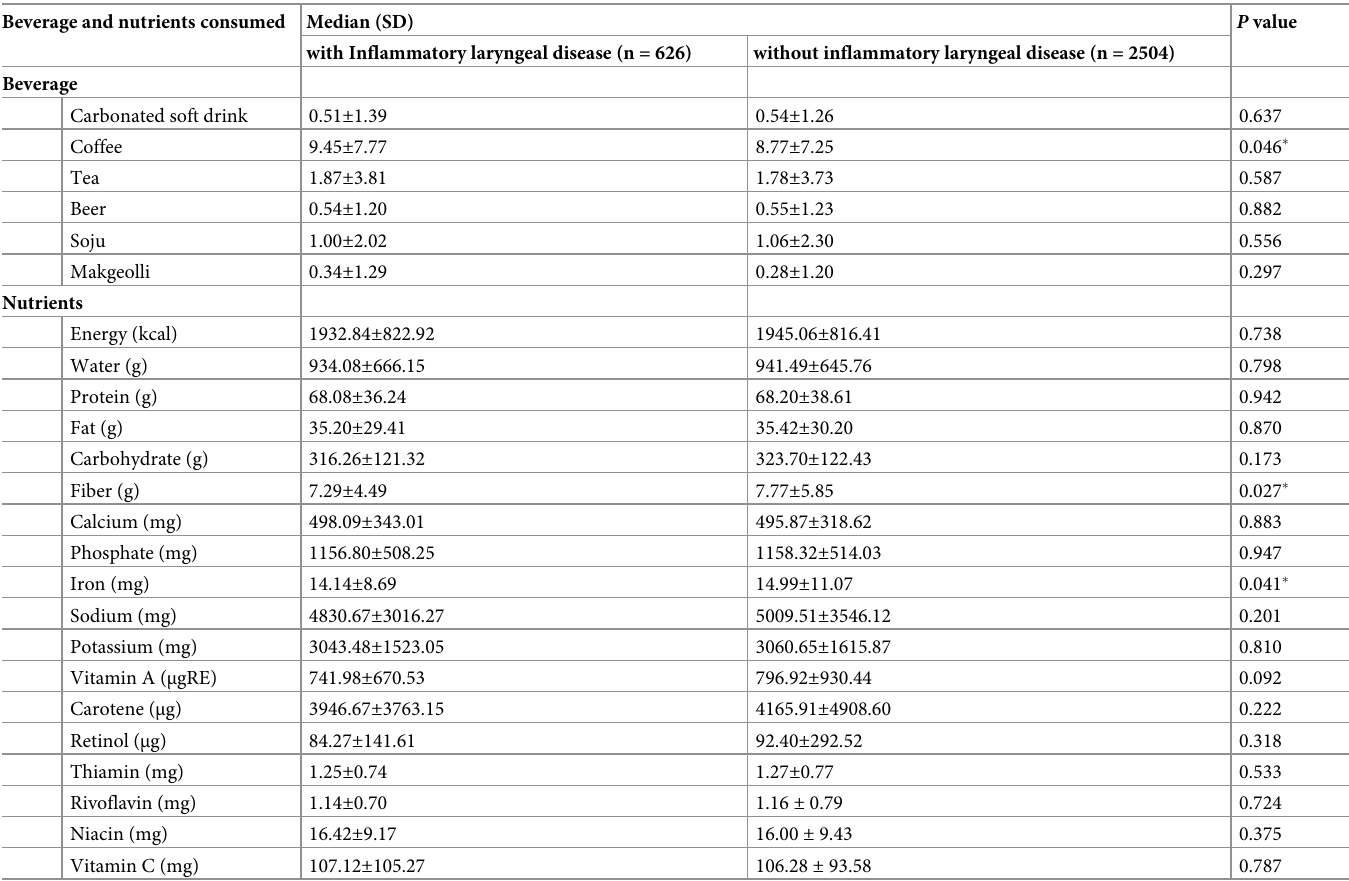
Table 3. Beverage and nutrients median consumption pattern of